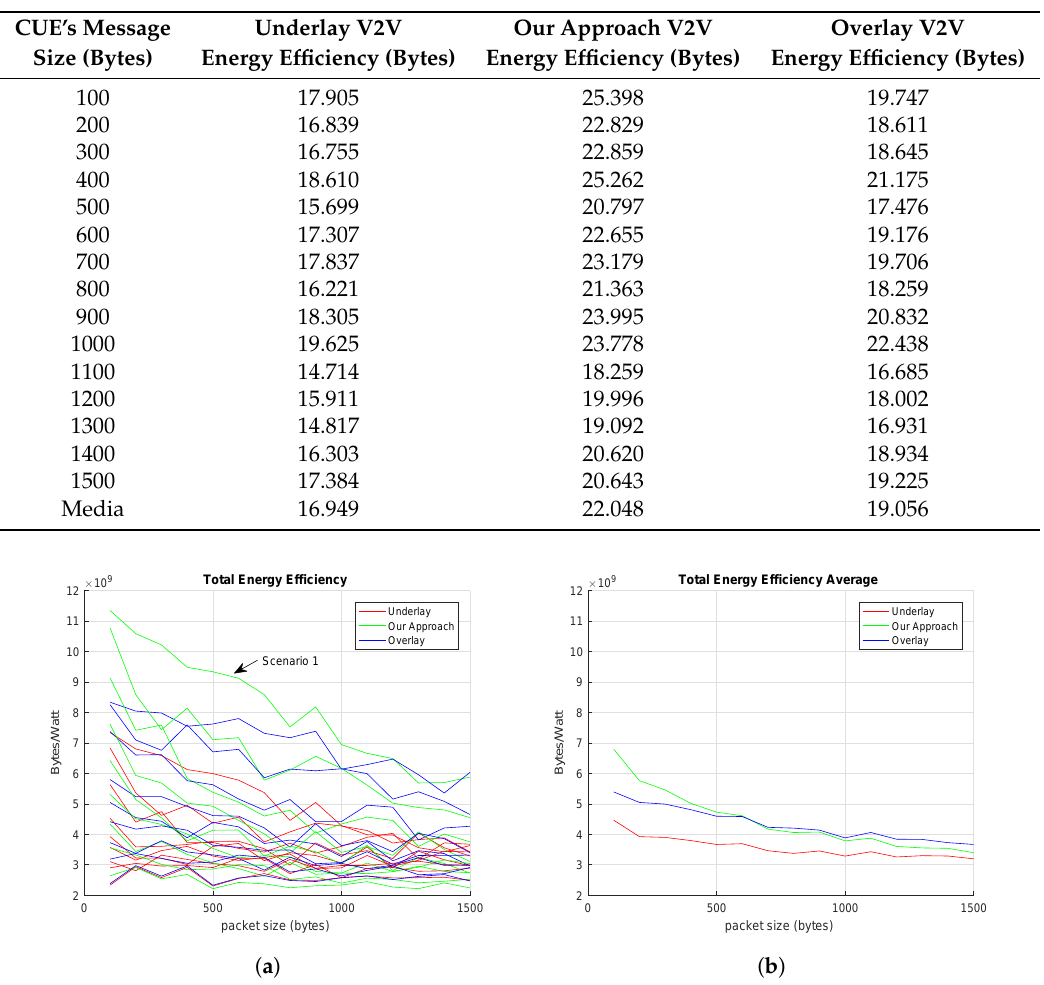
Table 7. Average Energy Efficiency offered to V-UEs based on C-UEs’ traffic pattern.